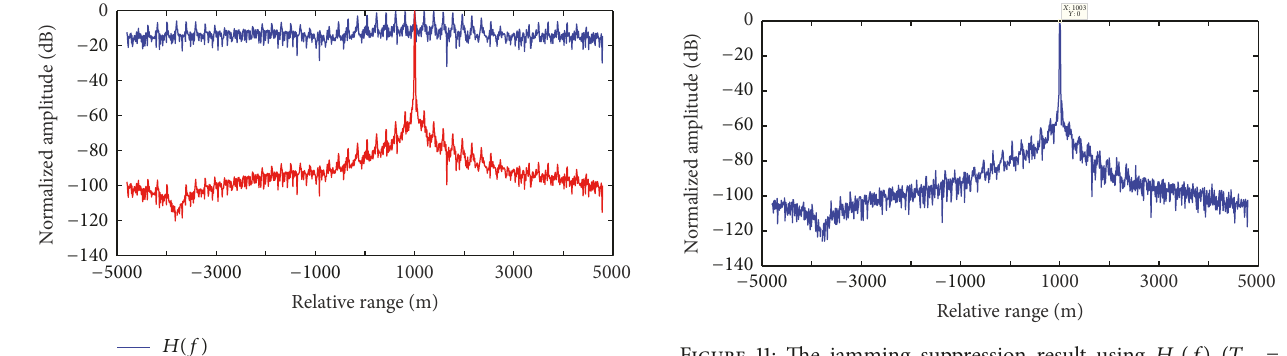
Figure 11: The jamming suppression result using 𝐻 𝑎 (𝑓) ( 𝑇 𝑠 = 10 𝜇 s).